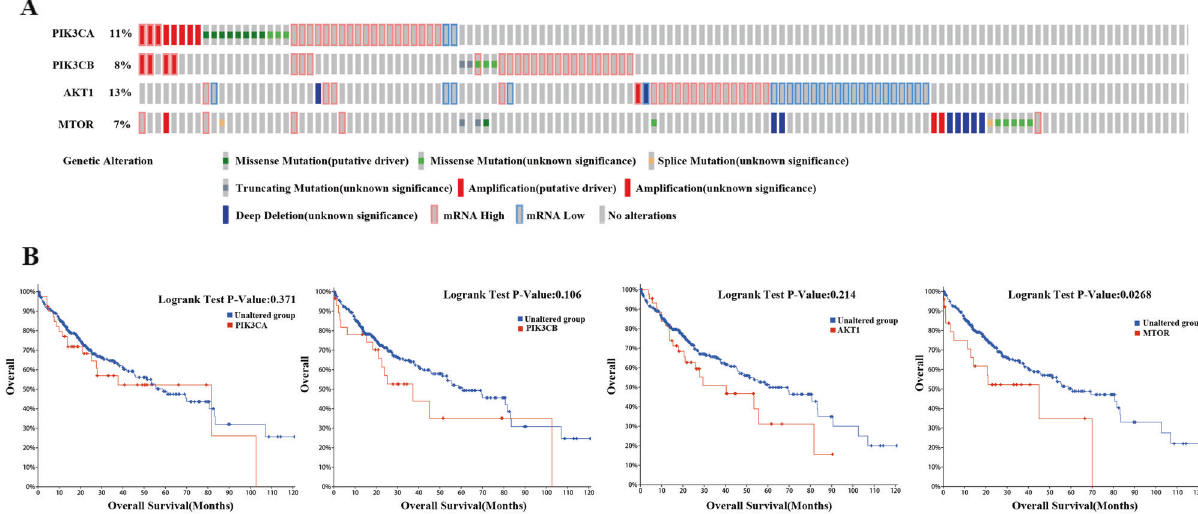
Fig. 1 The PI3K/AKT/mTOR pathway is active in hepatocellular carcinoma. A Oncoprinter showed the distribution and frequency of PI3K/ AKT/mTOR pathway-related gene mutations, copy number changes, and gene expression levels in liver cancer samples. B Analysis of survival differences in patients with liver cancer with PI3K/AKT/mTOR gene mutations from TCGA database (data source: https://www.cbioportal.org/).